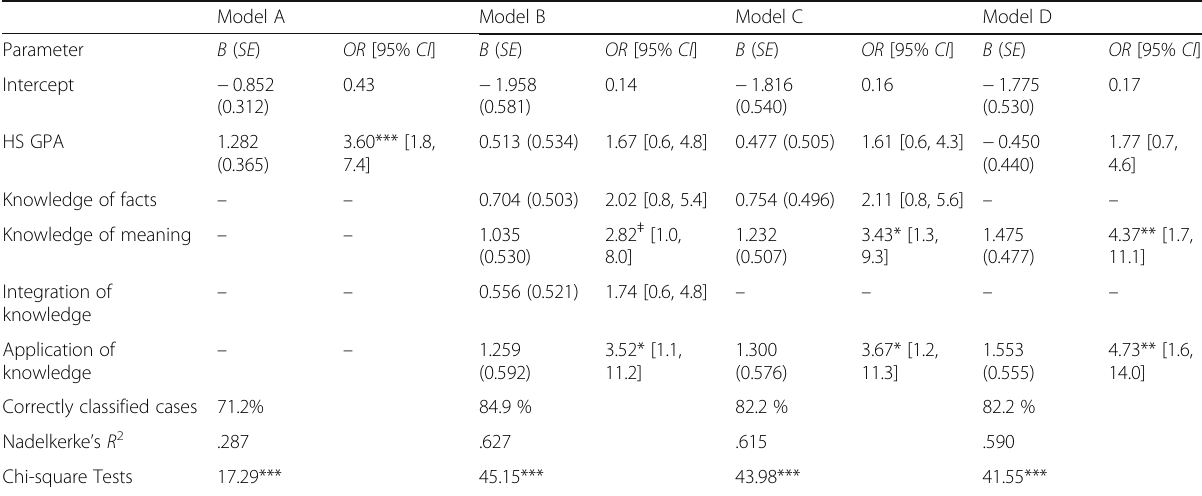
Table 3 Summary of the logistic regression analysis for academic achievement in